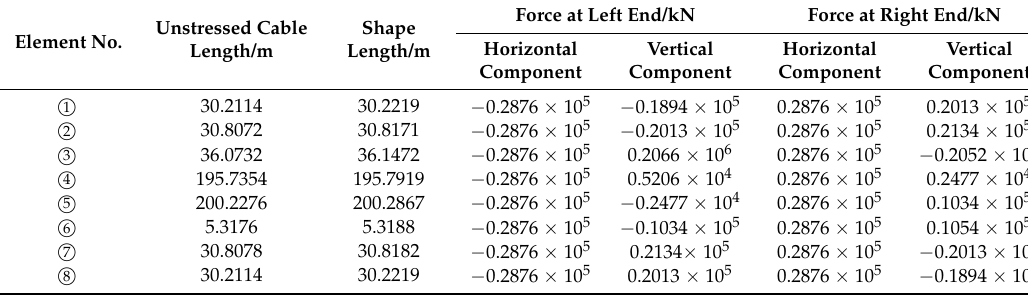
Table 3. Results of the length and tension force of each cable element under load case 2.